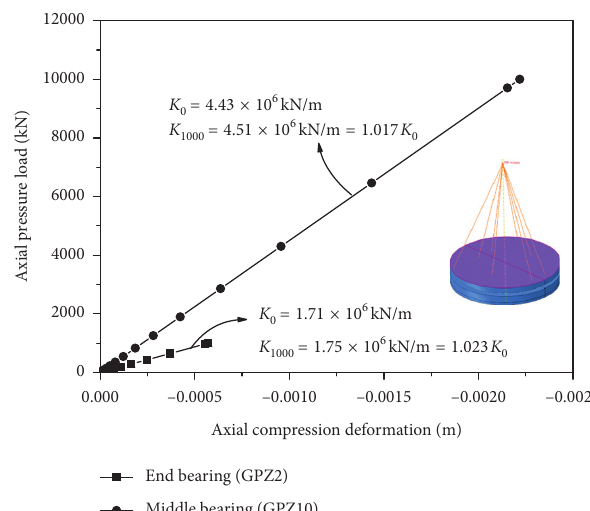
Figure 8: Axial load-deformation relationships of the pot rubber bearings.